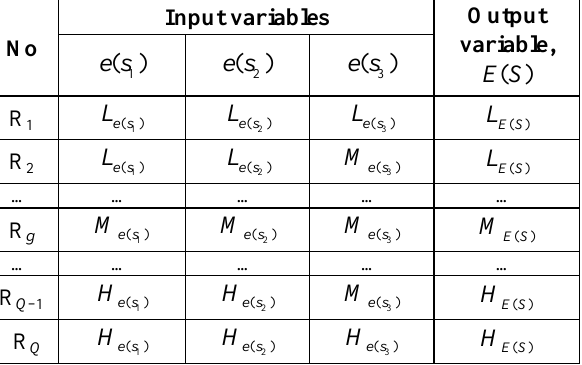
Table 1. The fragment of fuzzy rules base of